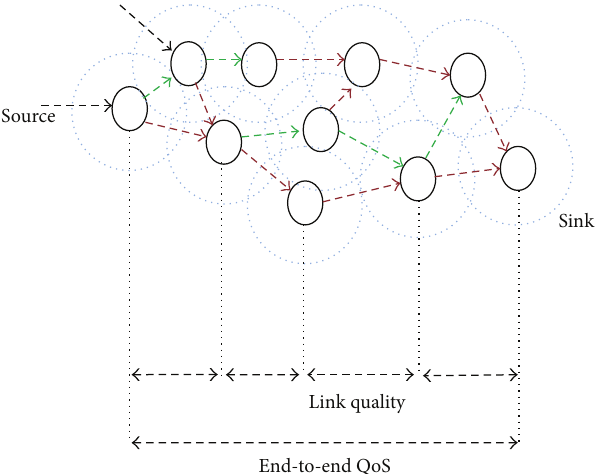
Figure 2: Partitioning QoS requirements at all down-stream